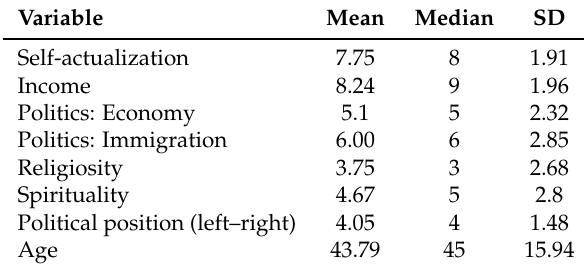
Table A6. Descriptives of metric and original predictor